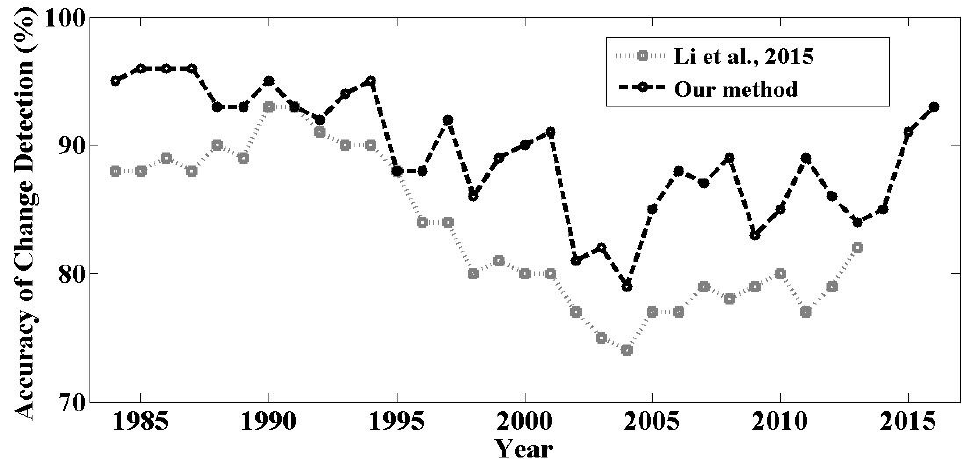
Figure 5. Time series of overall accuracy for changes detected in and around Beijing during 1984–2016. The method proposed in this paper (dark dashed line) is compared against that employed by Li et al. [21] (grey dotted line).